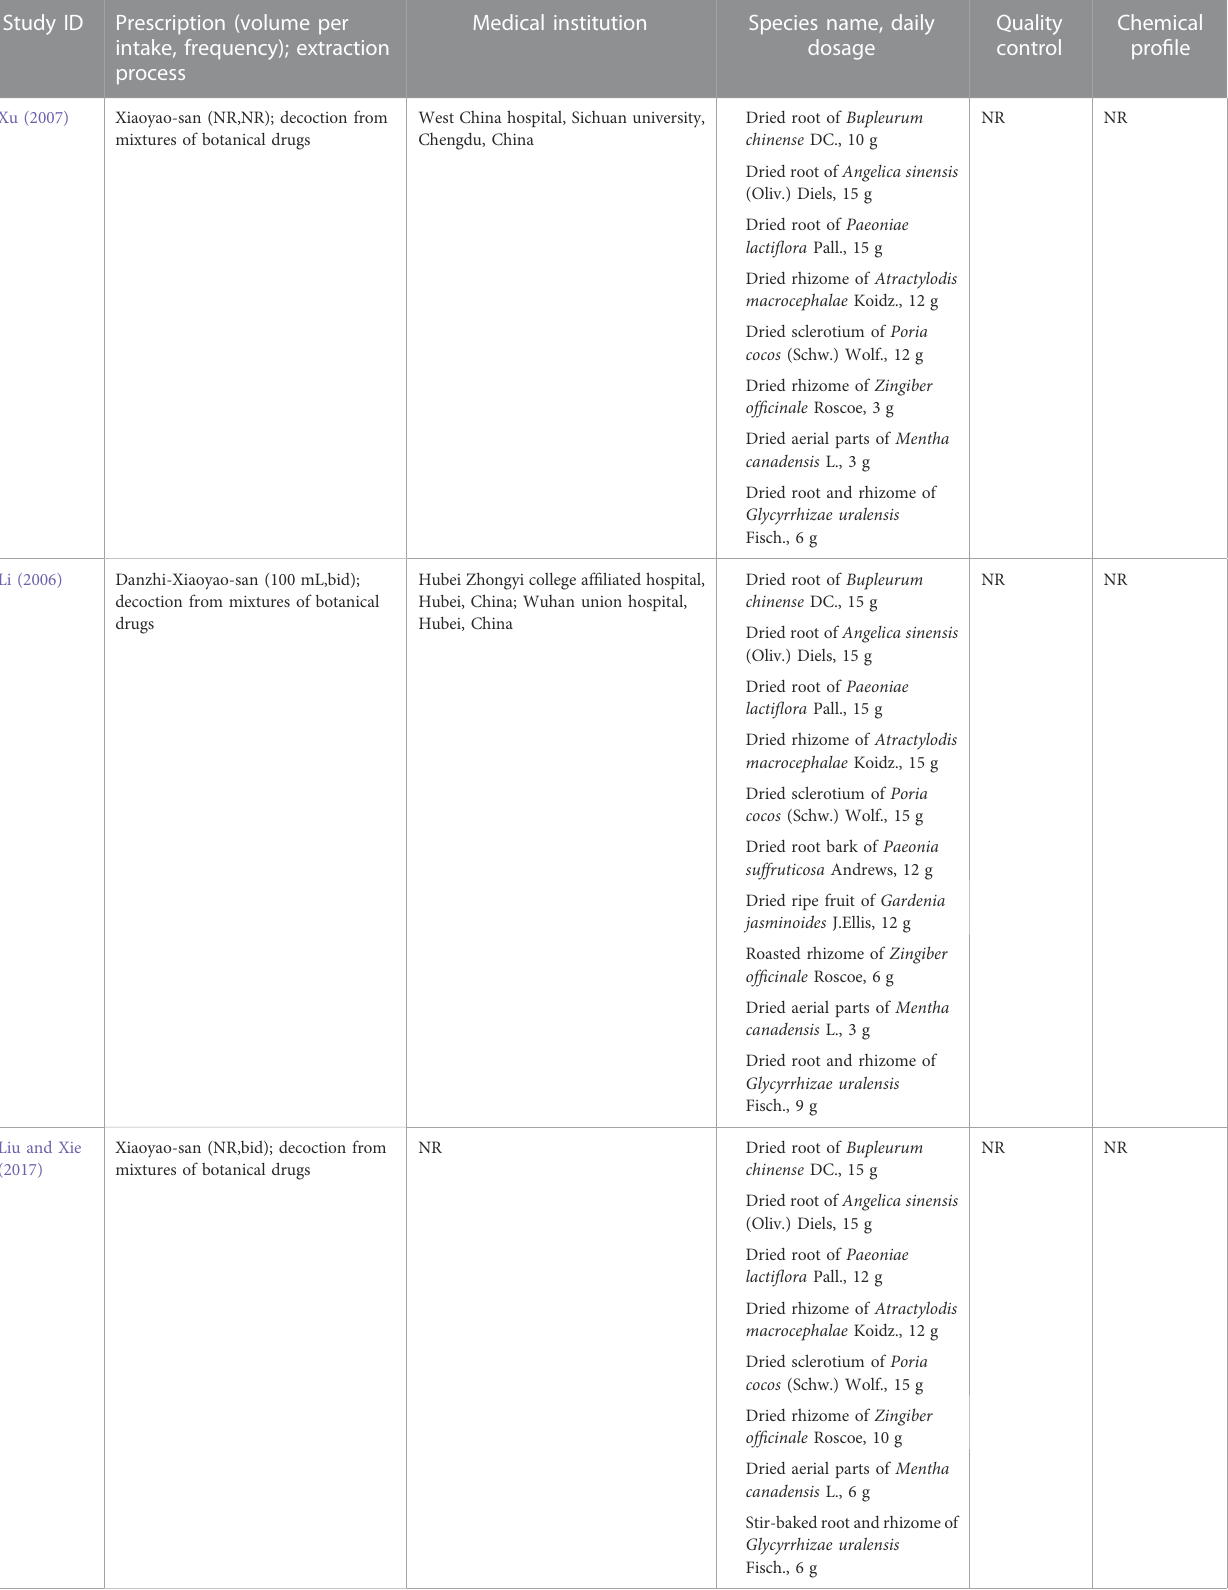
TABLE 3 ( Continued ) Herbal prescription and its components in the included